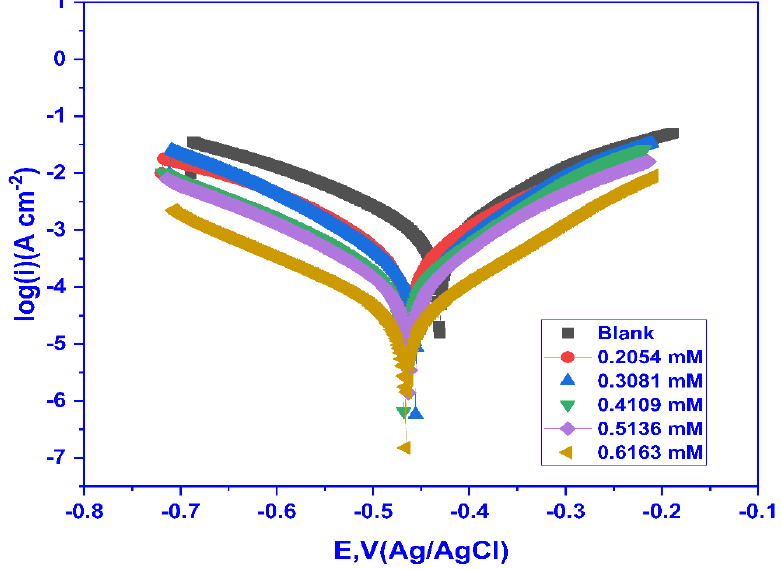
Figure 5. OCP vs. Time plot for MS in 1 M HCl solution with and without varying doses of CMEA.